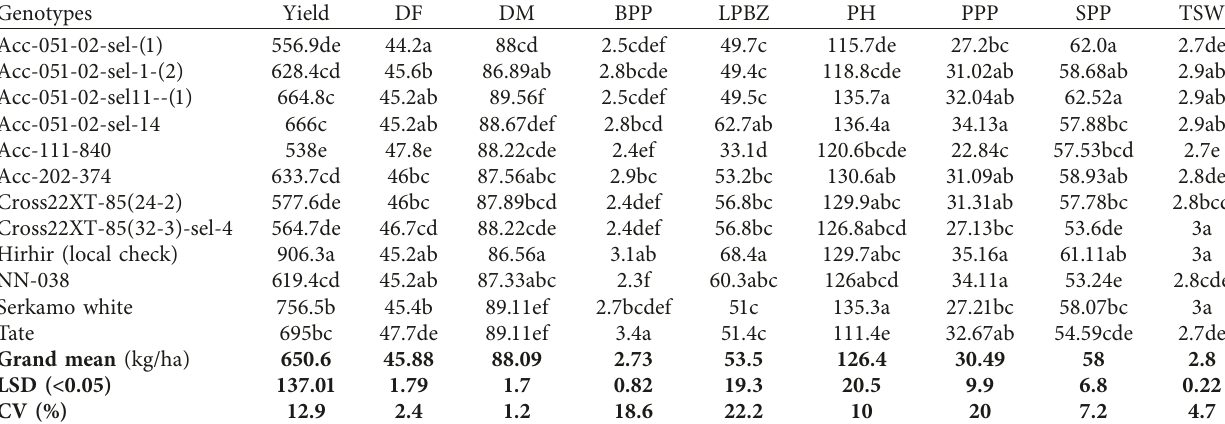
Table 4: Combined mean yield (kg/ha) and yield components of the sesame genotypes evaluated in three years.